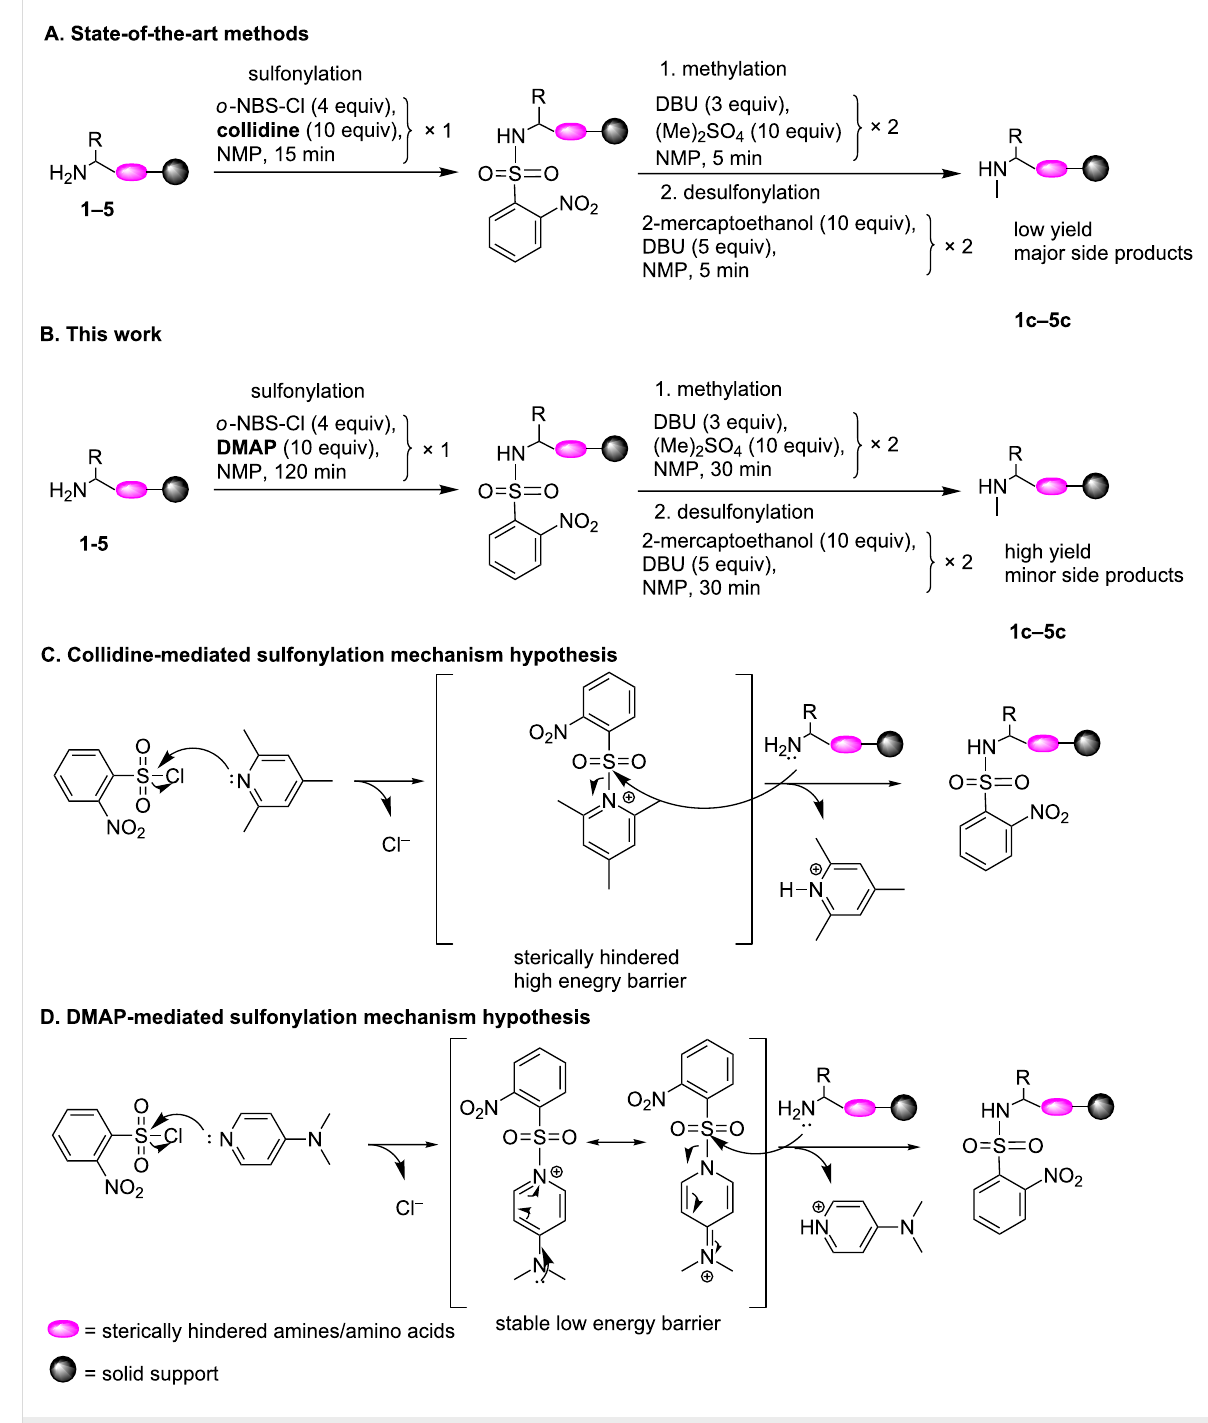
Figure 1: Collidine-assisted vs DMAP-assisted N -methylation process on solid support. (A) Collidine-assisted methylation of amines on solid support via a state-of-the-art method. (B) DMAP-assisted methylation of amine motifs on solid support as reported in this study. Comparative sulfonylation nucleophilic addition type mechanism as demonstrated for (C) collidine-mediated sulfonylation and (D) DMAP-mediated sulfonylation.